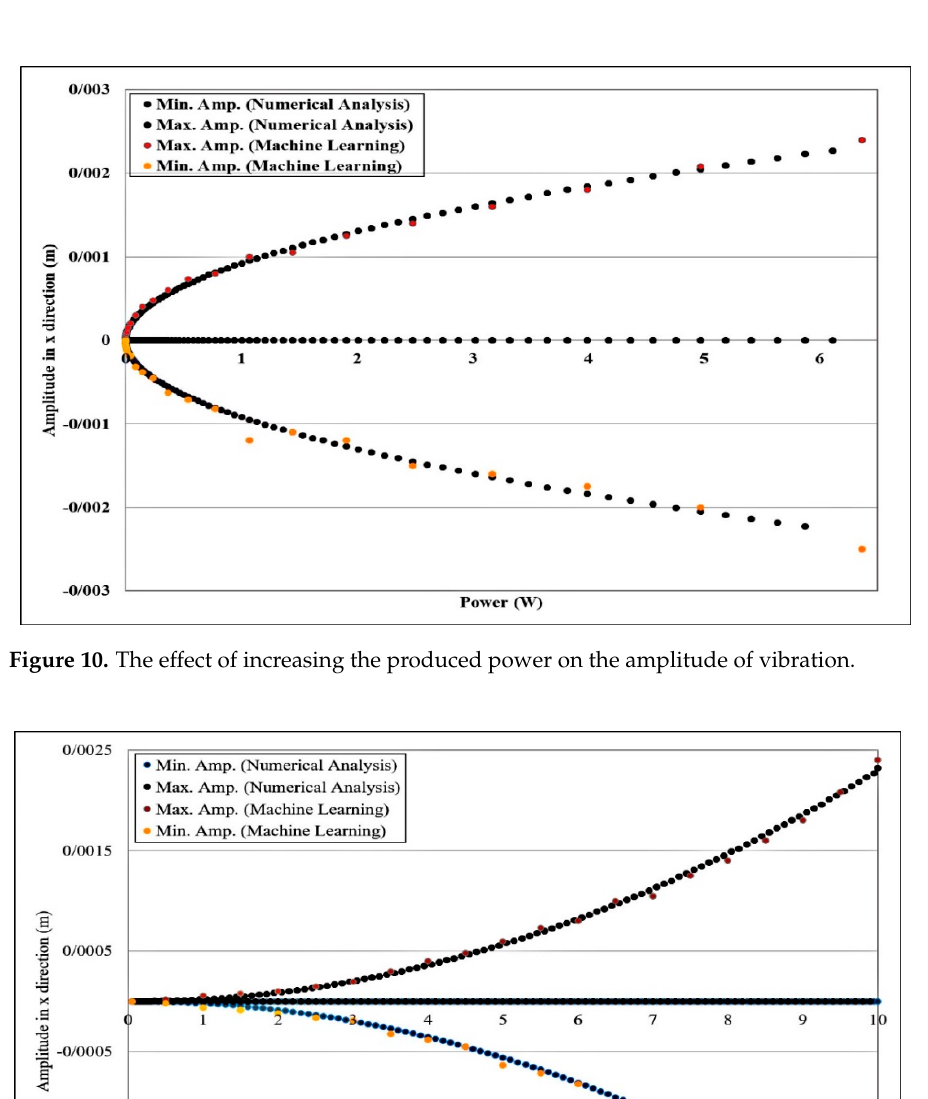
Figure 11. The effect of increasing the wind flow velocity on the amplitude of vibration.